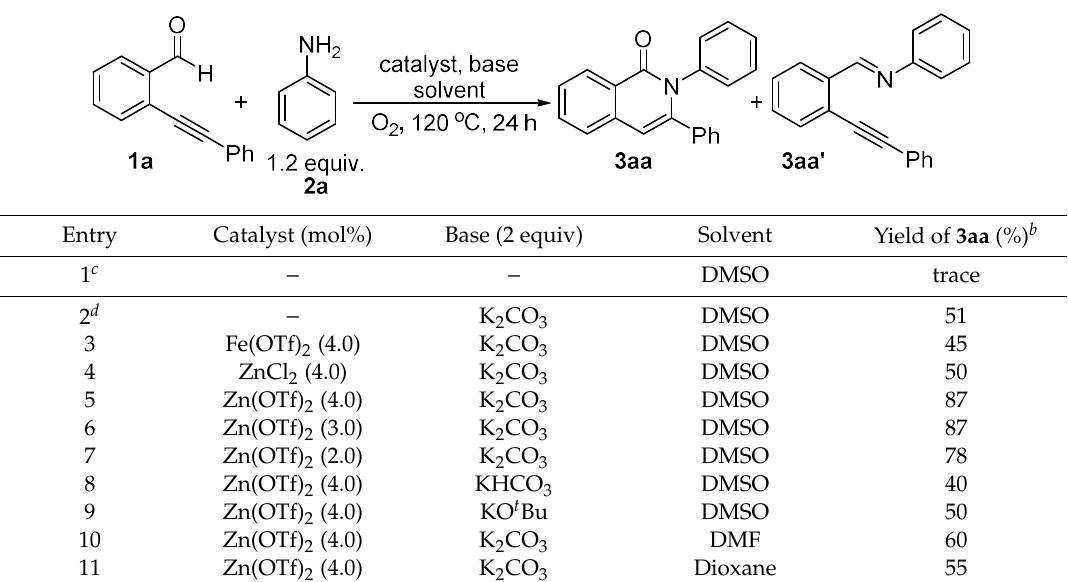
Table 1. Optimal conditions for the formation of 2,3-diphenylisoquinolin-1(2 H )-ones (2a) a .